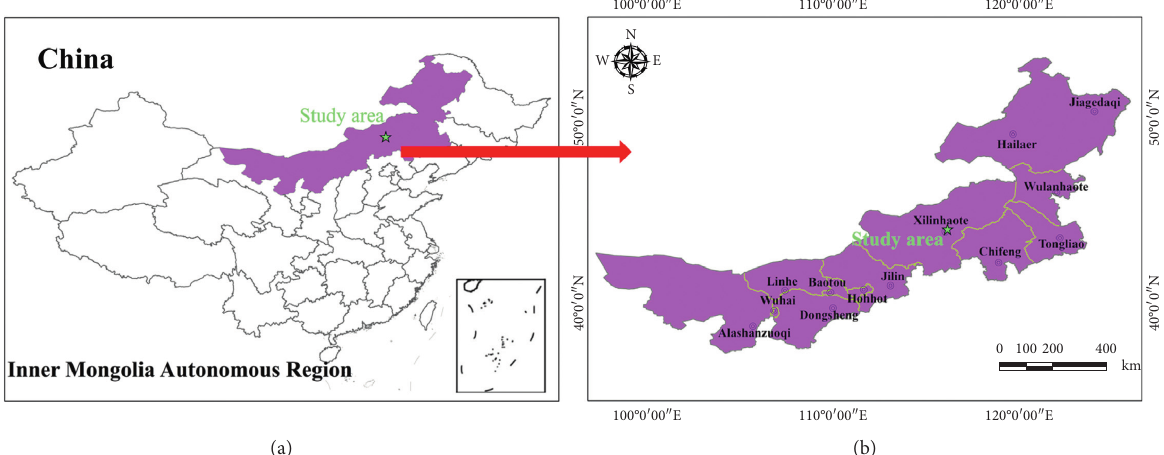
Figure 1: Location of the study area. (a) The study area in the Chinese map. (b) The study area in Inner Mongolia autonomous